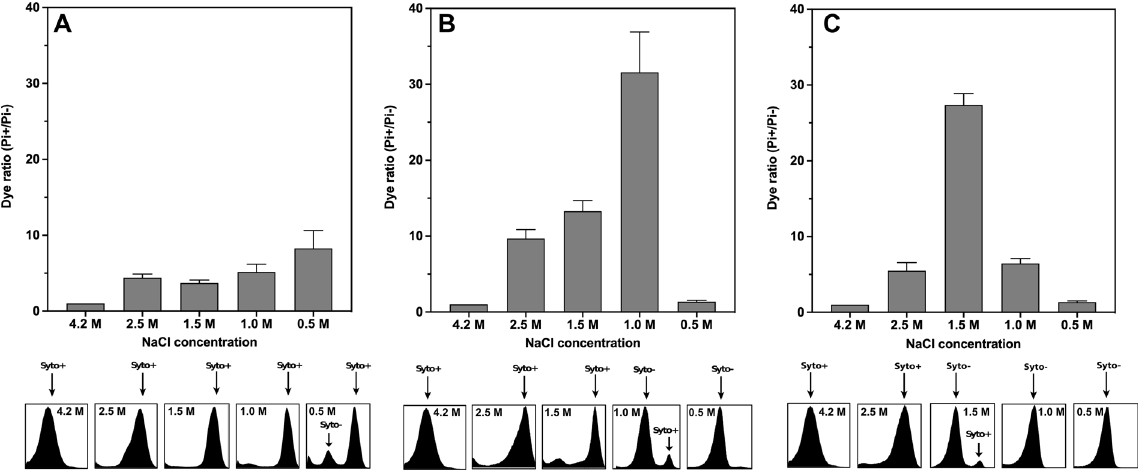
Figure 2. Flow cytometry analysis of membrane integrity (PI labeling) and DNA staining (Syto labeling) of Hbt. salinarum cells. The cells were incubated for 1 hour ( A ) and 24 hours ( B ) and 7 days ( C ) in standard growth medium (4.2 M NaCl, control) or in low NaCl conditions (2.5 M, 1.5 M, 1.0 M and 0.5 M At the top, PI + (membrane integrity) cell populations detected at 645 nm (PI). At the bottom, histograms of Syto9 (DNA labelling) staining showing changes in the fluorescence intensity (at 528 nm) of cells exposed to various salt concentrations. Damaged (Syto − ) and undamaged DNA (Syto + ) populations are indicated by arrows. Each experiment was carried out in triplicate. Errors bars represent standard